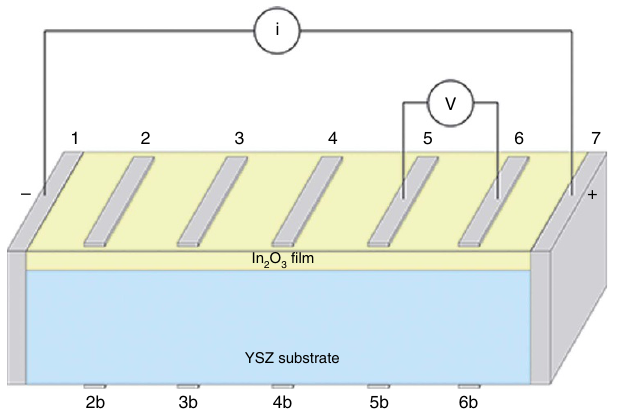
Figure 1 | Sample schematic. Equally spaced Pt parallel line electrodes (voltage pick-offs) were sputter-deposited through a shadow mask on the films (numbered 2–6) and, for some samples, on the other surface of the YSZ substrate (2b-6b). The current electrodes (numbered 1 and 7) were Ag or Pt paint.